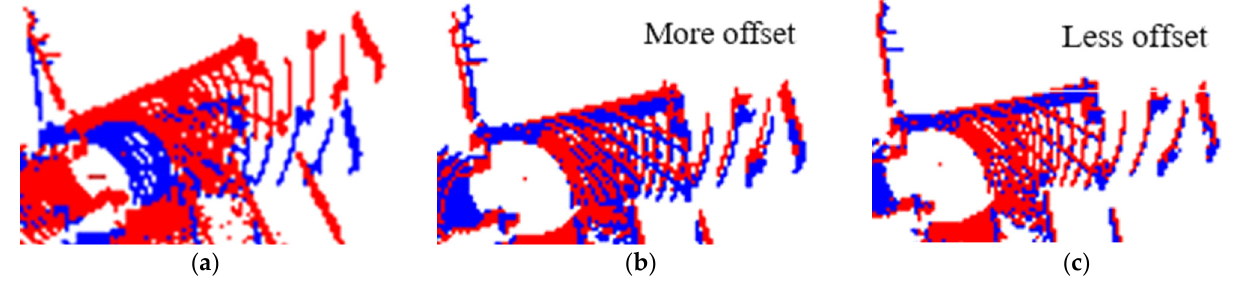
Figure 8. Detail diagram of point registration results of the point cloud registration results. ( a ) Original source and target point clouds. ( b ) Alignment results using ICP algorithm. ( c ) Alignment results using our algorithm.